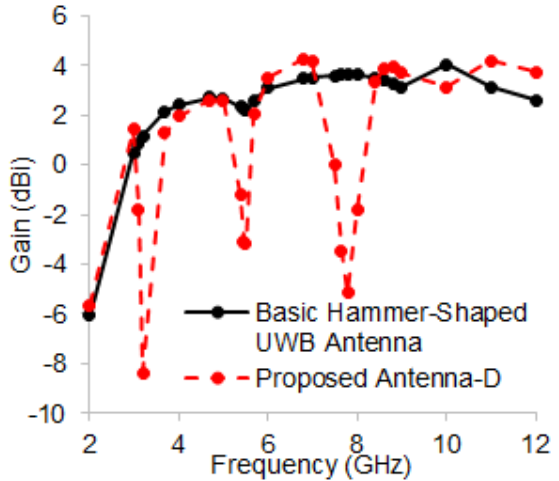
Figure 10: Gain comparison of proposed triple band notched hammer-shaped